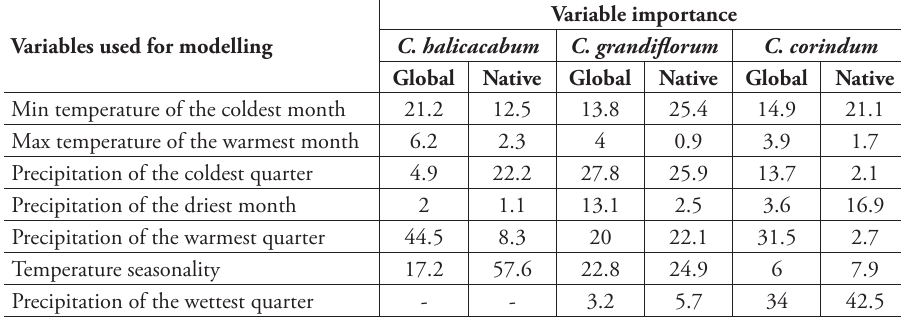
Table 2. Contribution (%) of each BioClim variable used for distribution modelling of Cardiospermum species. The first value in each species column is for global and the second for native range modelling. Variables used for